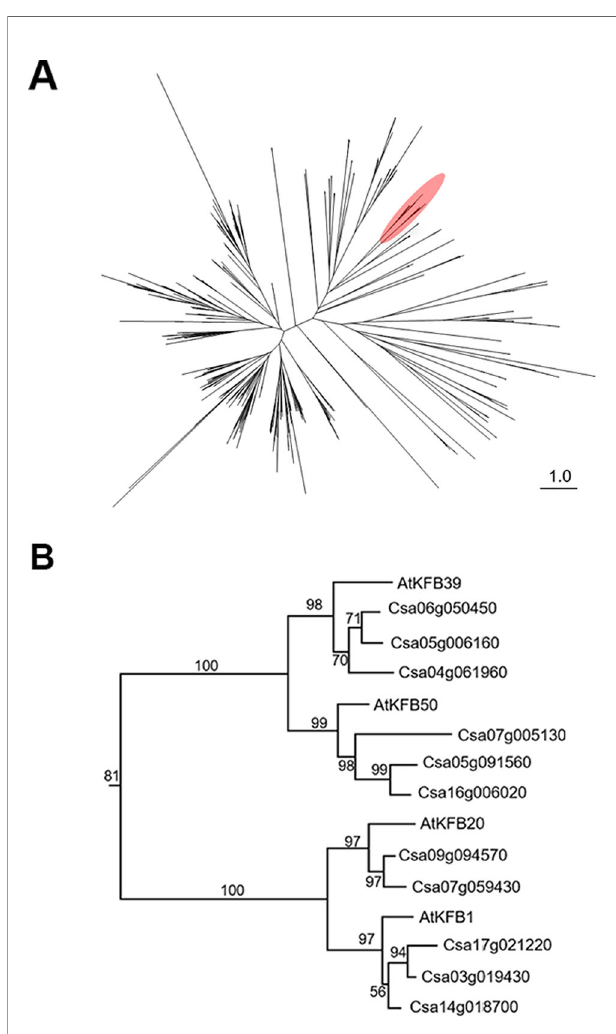
FIGURE 5 | Phylogenetic analysis of Kelch-domain containing F-boxs (KFBs) in Camelina. (A) Maximum likelihood phylogenetic tree of C. sativa orthologs of four Arabidopsis genes (AtKFB1, AtKFB20, AtKFB39, AtKFB50). A radiation diagram is used to represent an unrooted maximum likelihood tree with branch lengths proportional to estimated sequence distance. A total of 459 nonredundant proteins containing kelch-motif(s) were identi fi ed. A clade including four Arabidopsis KFBs (AtKFB1, AtKFB20, AtKFB39, AtKFB50) is shown in red. (B) A phylogenetic tree of AtKFB1, AtKFB20, AtKFB39, and AtKFB50 homologs in Camelina shows 11 genes having high sequence similarity with AtKFBs functioning in Phenylalanine ammonia lyase (PAL)